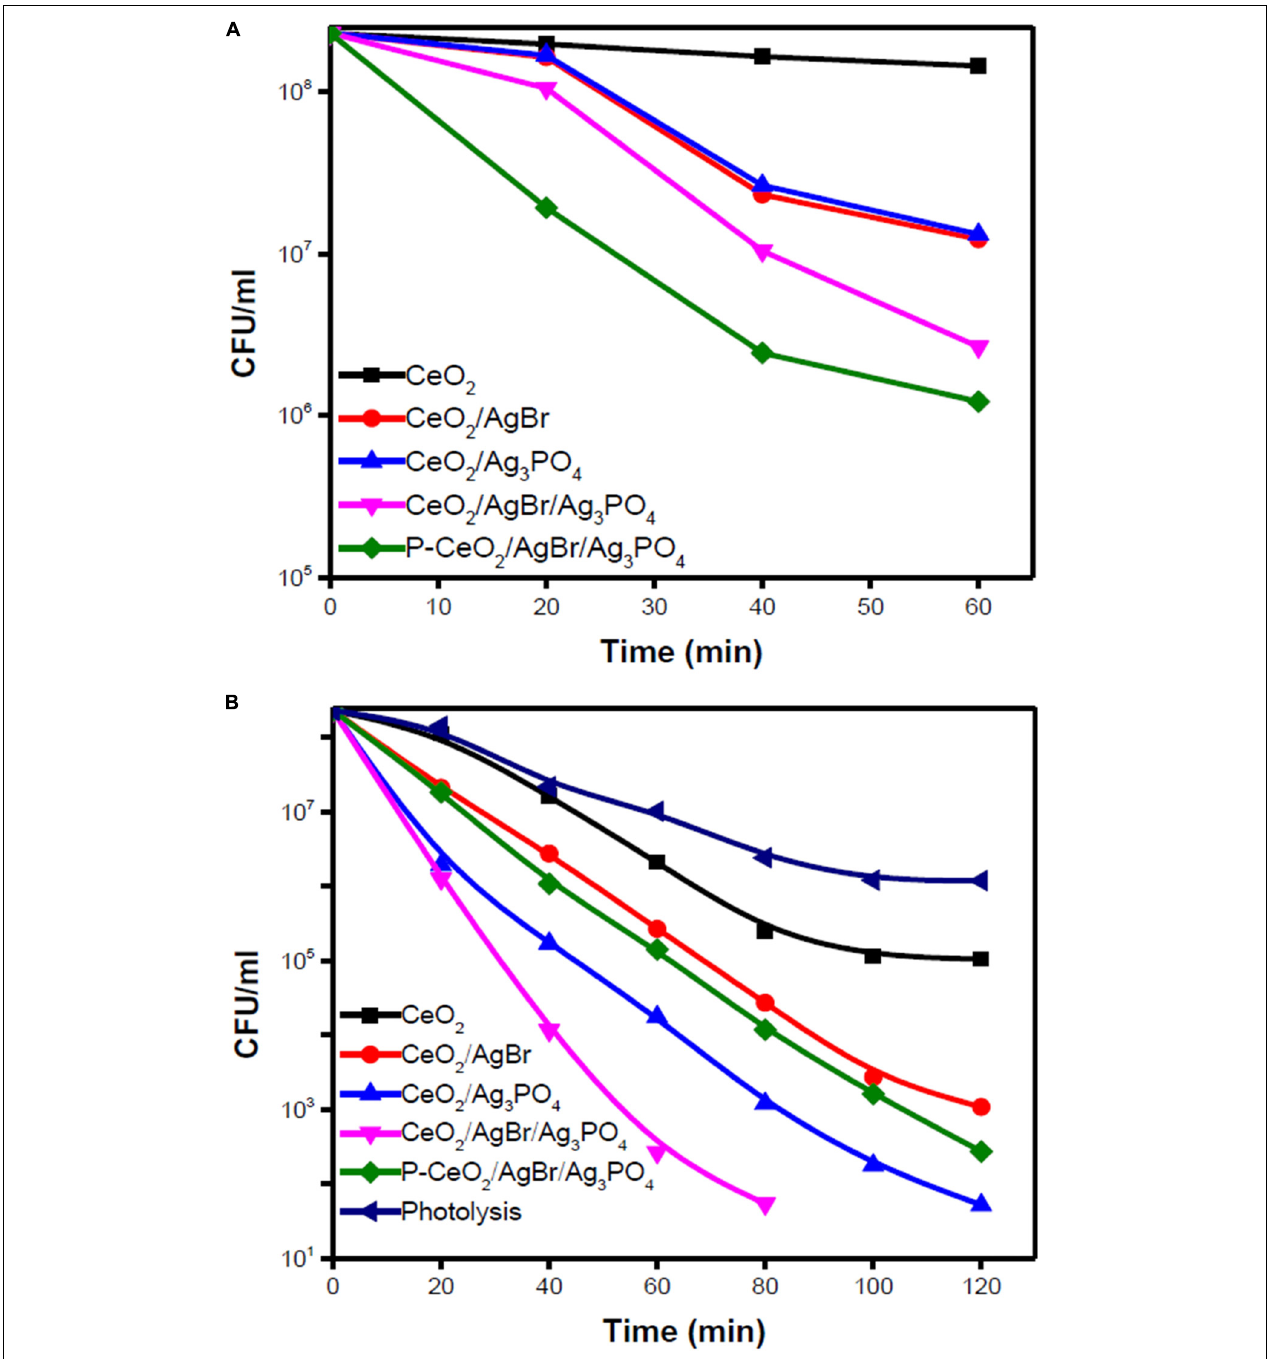
FIGURE 3 | Photocatalytic degradation of Escherichia coli using ceria/Ag 3 PO 4 , ceria/AgBr, and ceria/Ag 3 PO 4 /AgBr composites against (A) dark and (B) visible light. Reprinted with permission from Eswar et al. (2015), copyright 2015 American Chemistry Society.